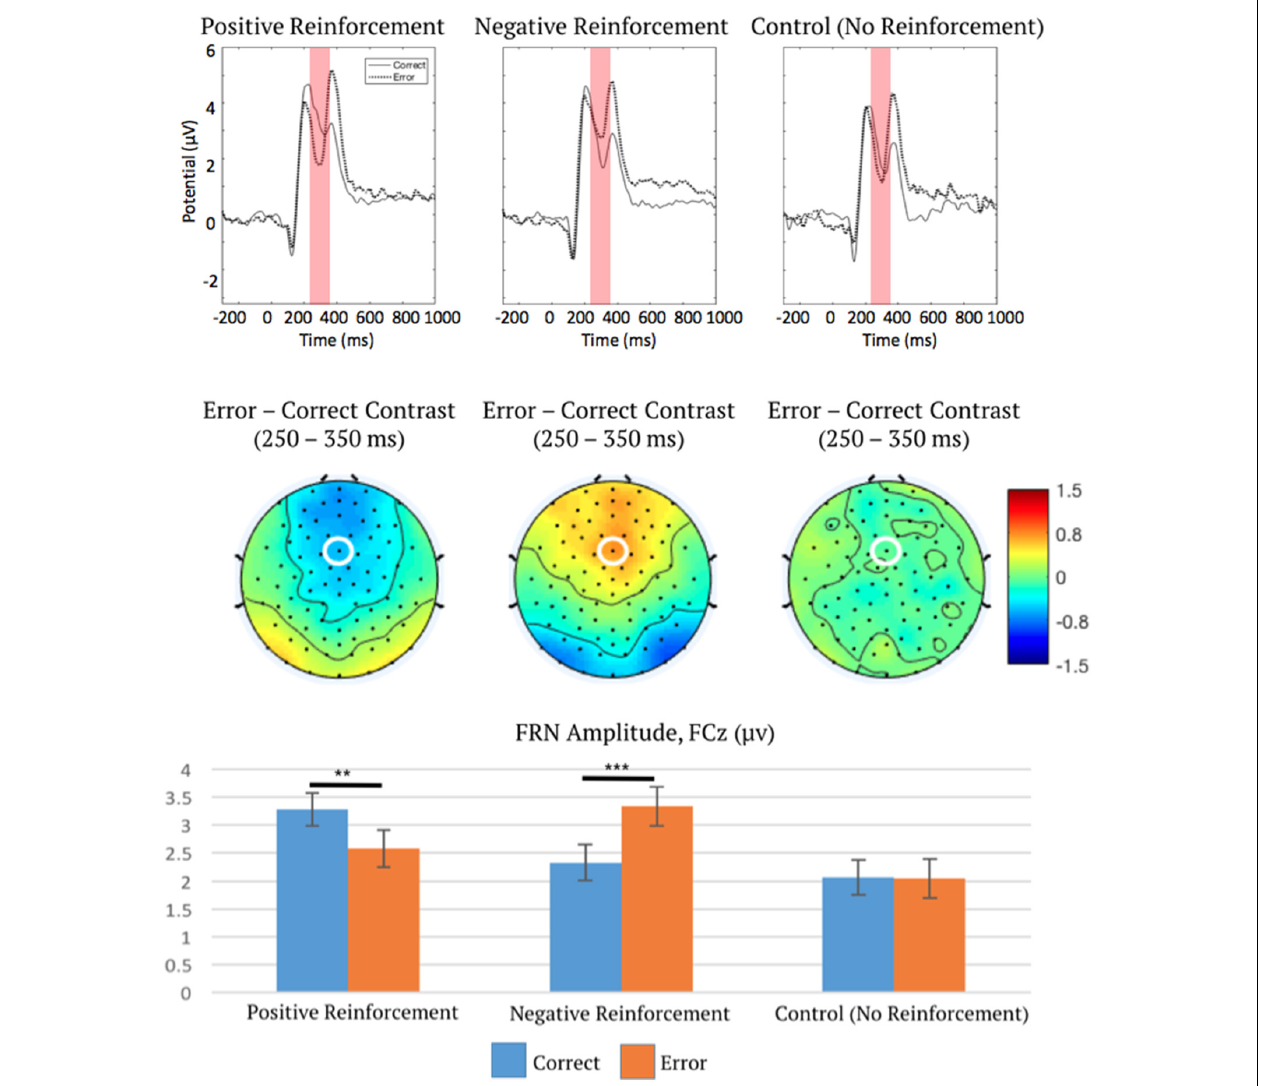
FIGURE 4 | ERP waveforms measured at FCz (top), topographic distributions of the error-correct difference in the FRN time window (middle), and mean FRN amplitudes (bottom), depicting interaction effect of reinforcement type and outcome on FRN. This plot describes the interaction effect of reinforcement type and outcome as confirmed via ANOVA, therefore all ERP waveforms are collapsed over low, medium, and high point levels. Note ERPs are plotted negative downward, such that larger FRN activation is depicted as a waveform drop. FCz is marked by a white ellipse. The shaded region is the time period across which the FRN was measured. Error bars represent 1 ± SEM. ∗∗ p < 0.01, ∗∗∗ p <